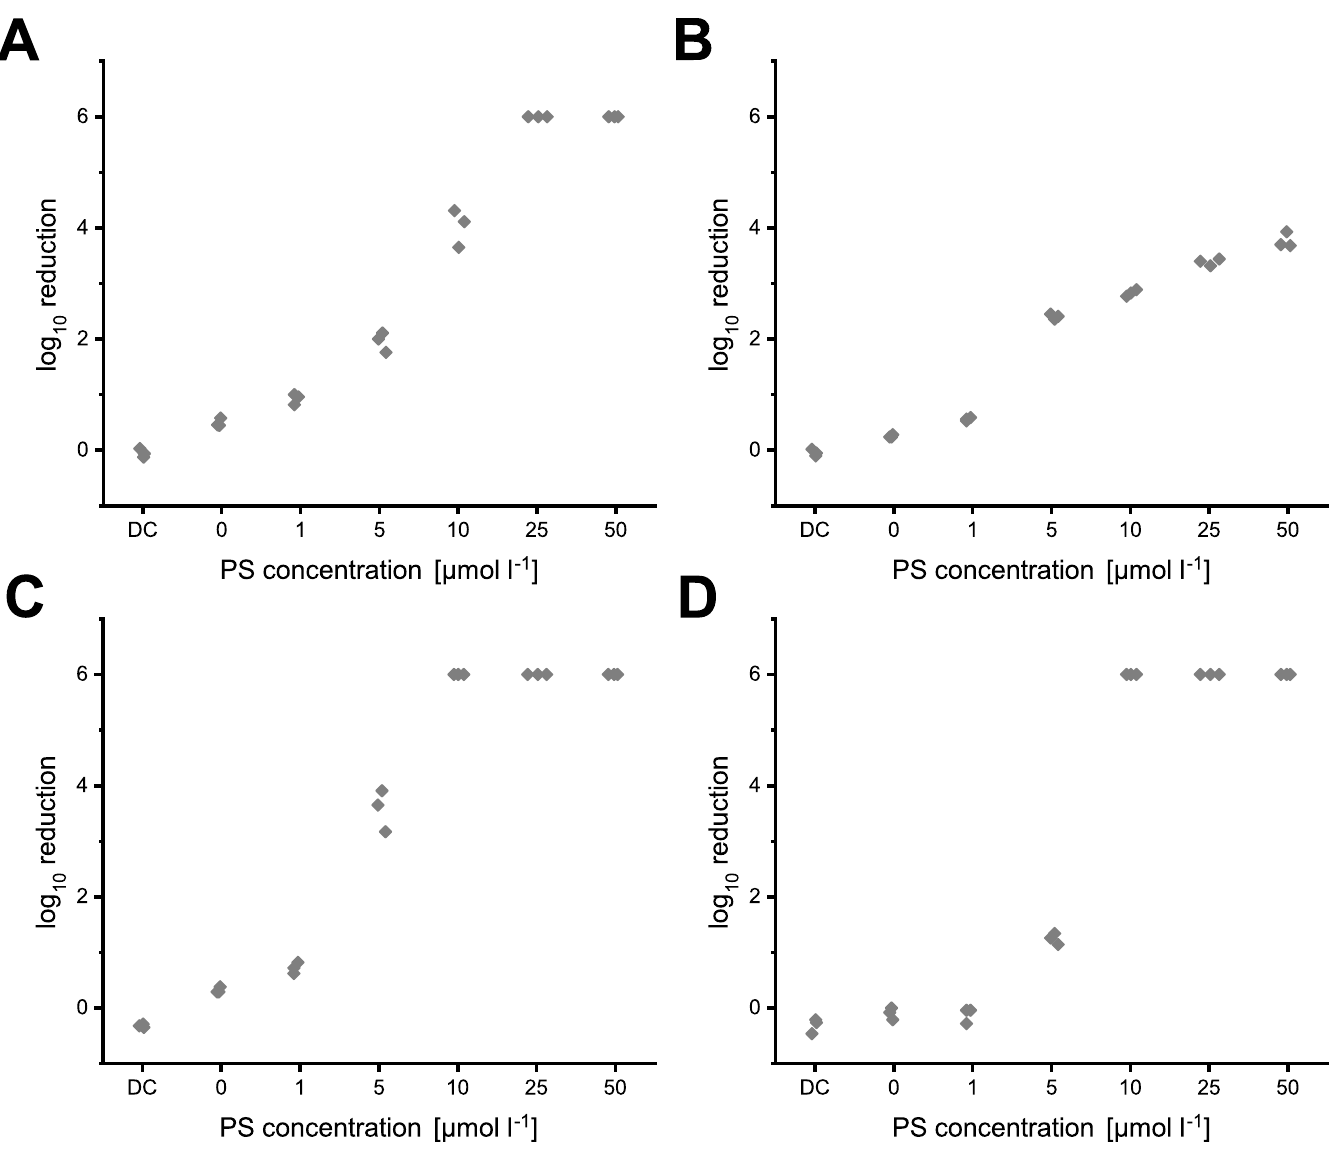
Fig 5. Results for the photodynamic inactivation without the application of ions. Logarithmic reduction values of S . aureus with FLASH-02a (A) and FLASH-06a (B) compared to the logarithmic reduction of P . aeruginosa treated with FLASH-02a (C) and FLASH-06a (D). Y axis of the graphs indicate the decadic logarithmic reduction while the x axis displays the different concentrations of the applied PS with DC indicating the dark control (no irradiation, 50 μ mol l -1 PS). As each experiment was carried out by n = 3, each dot represents one single value from a single experiment.